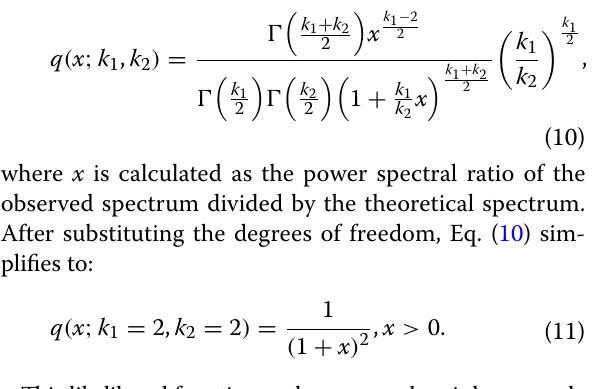
bution. This study further compared results generated by both F -distributions and normal distributions used as probability density function. In every sampling iteration, we calculate likelihood using probability density functions by substituting sample parameters for the ratio of the squared observed amplitude spectrum and the squared theoretical amplitude spectrum. To obtain one likelihood for records from all stations, we use the product of likelihood from each station. The